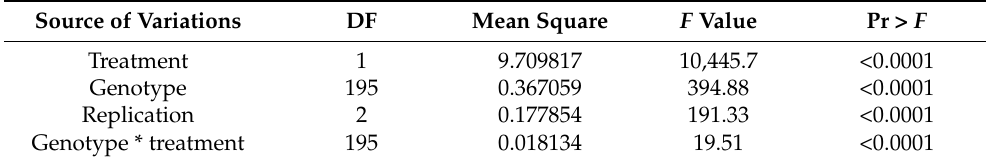
Table 3. ANOVA result for grain